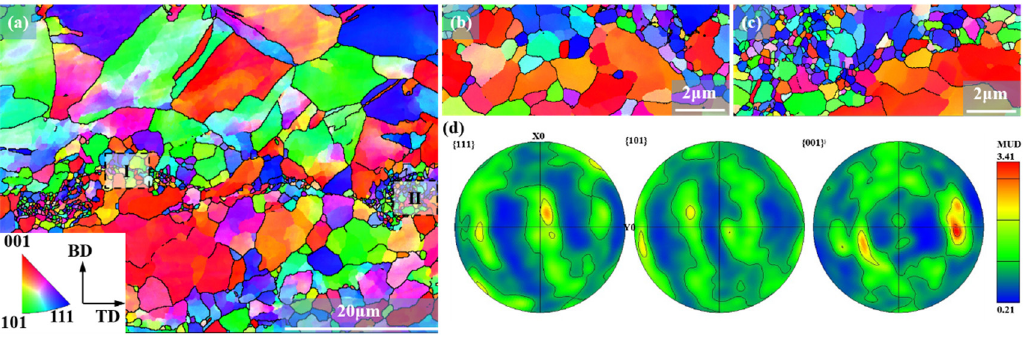
Figure 15. EBSD maps with the corresponding pole figures: ( a ) IPF, IPFs in zone I ( b ) and II ( c ), ( d ) PFs. The orientation distribution function (ODF) diagram can be used to quantitatively and accurately analyze the spatial distribution of the grain orientation in the texture material to further characterize the microstructure of the weld (Figure 16). The ODF map was measured to obtain the Euler angle, and the Euler angle was used to calculate the micro-textures in different regions. It can be seen that there are {001} <100> cubic textures, {001} <110> rotating cube textures and {111} <143>, {221} <122> deformation textures in the Cu-ETP welds. This cubic texture is not the cubic texture of the base material but is instead produced during the recrystallization process with ultrasonic welding. The cubic texture in the base metal becomes the core of recrystallization under the action of ultrasonic excitation and welding pressure and finally grows into a new recrystallized cubic texture. The cubic texture is also one of the main recrystallization textures of face-centered cubic crystals. The deformation texture is produced by the plastic deformation of the joint during the welding process. The reason is that the base material grains are produced via plastic deformation, and the newly formed recrystallized grains are deformed during the ultrasonic welding